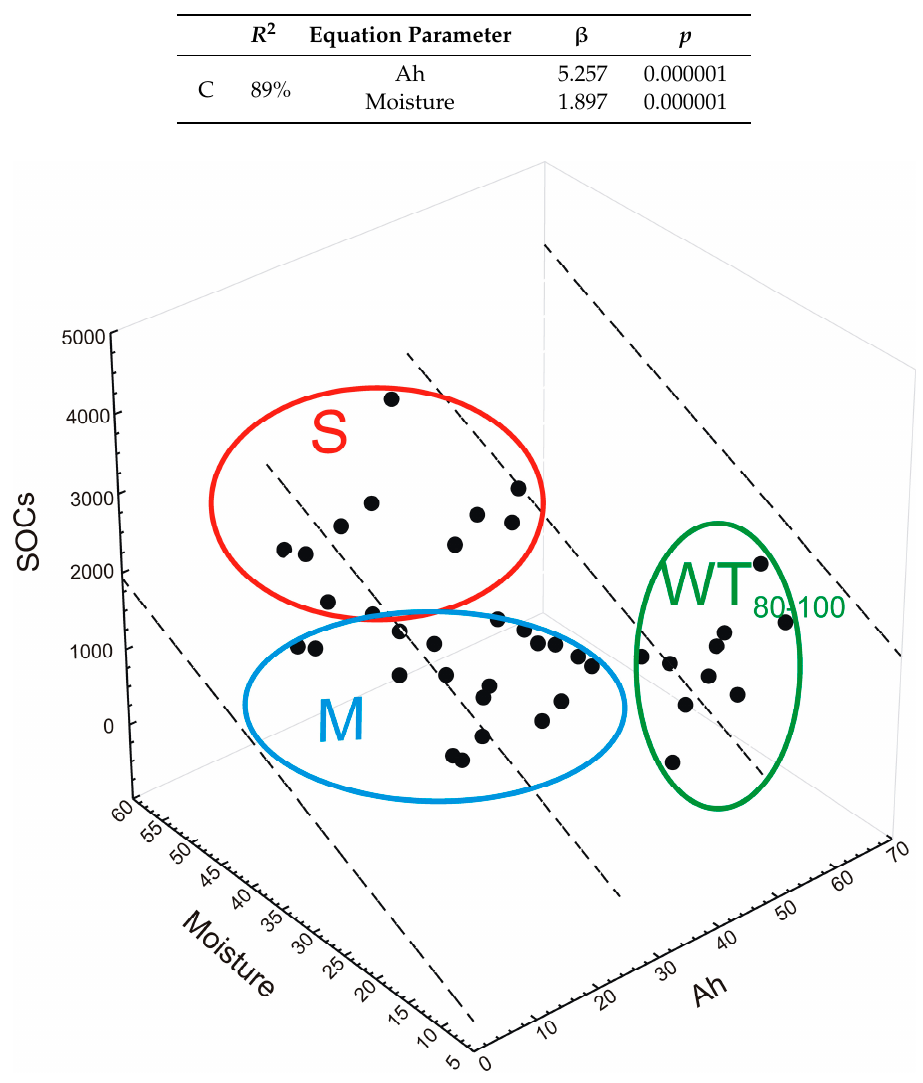
Table 5. Multiple regression analysis for carbon content based on soil characteristic. R 2 describes the percentage of explained variance, β is the regression coefficient for the given equation parameter and p is the significance level for the equation parameter.